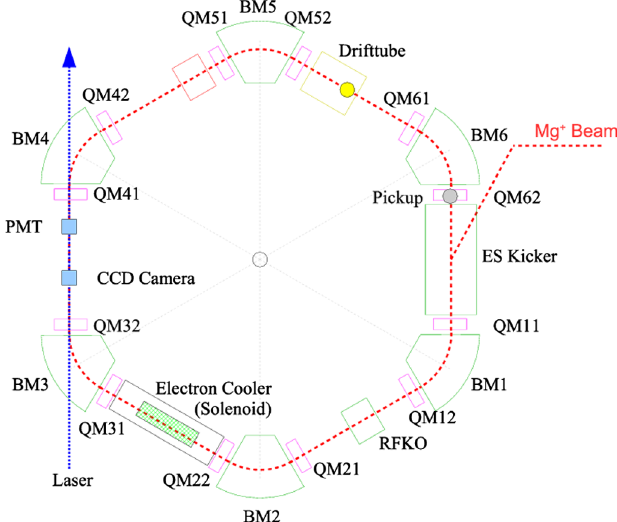
FIG. 1. Layout of the S-LSR It consists of 6 bending magnets BM i (the digit i indicates BM number) and 12 quadrupole magnets QM ij (focusing for digit j ¼ 1 , defocusing for digit j ¼ 2 , and digit i indicate QM number). The horizontal beam size was observed by CCD camera and PMT (photo multiplier